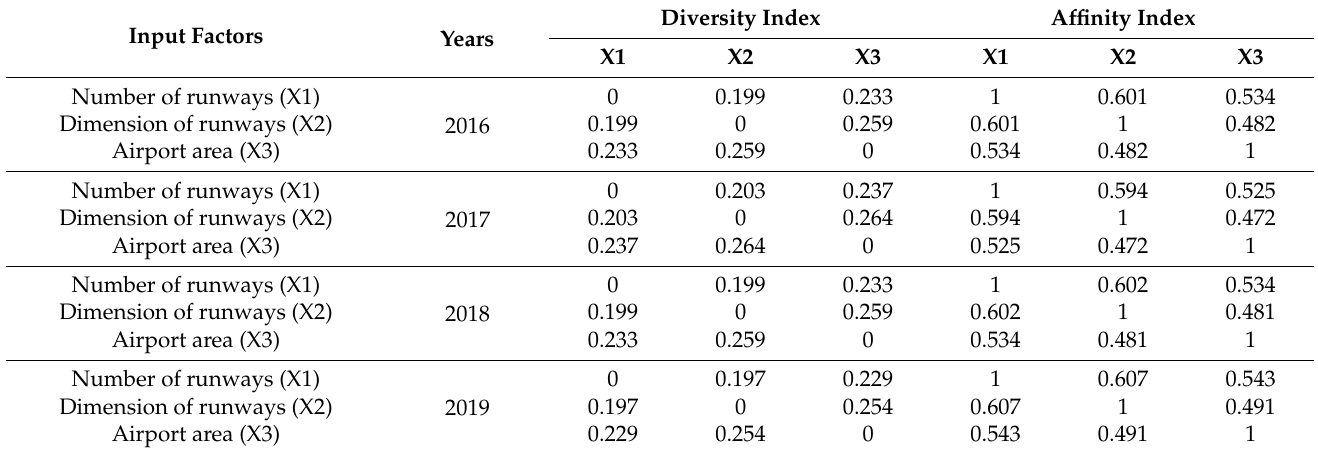
Table 6. The diversity and affinity matrixes of input factors during 2016–2019.